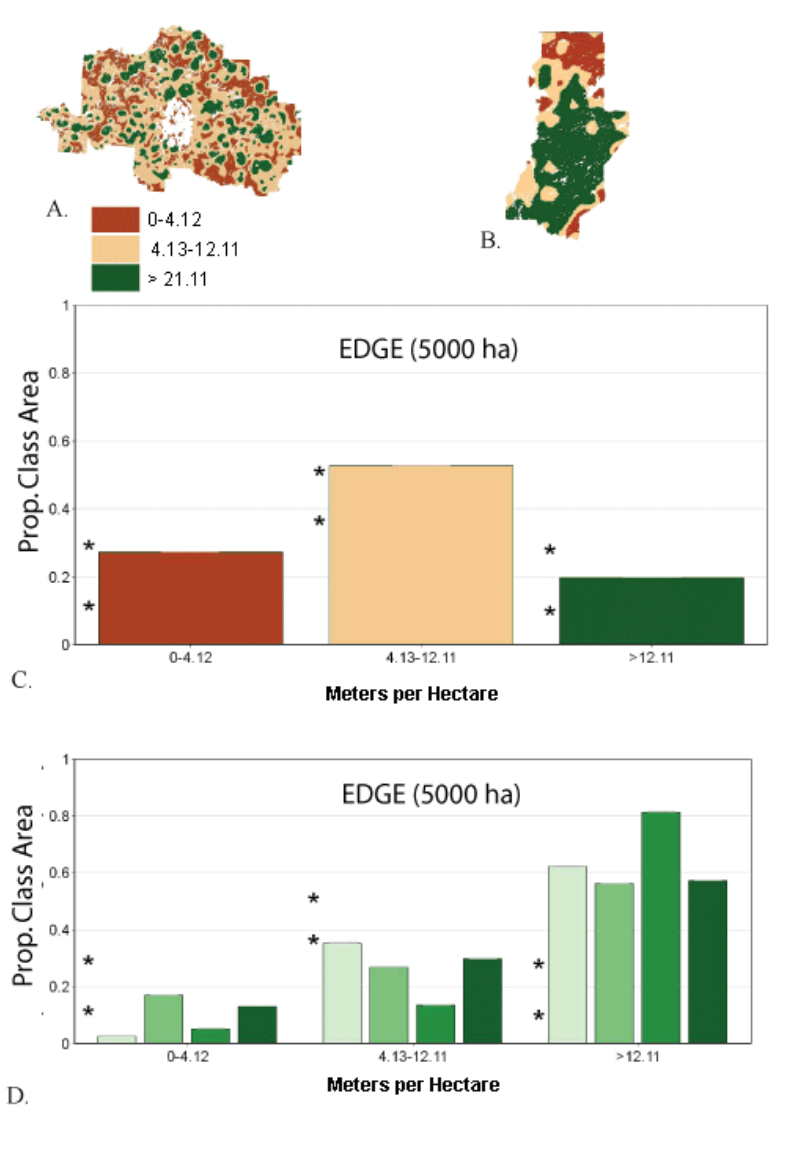
Fig. 7. Development and application of simulated range of natural variation (SRNV), and spatial pattern signatures: (A) 1 of 72 natural disturbance simulation maps (using BFOLDS) for ecoregion 3W, (B) projected map of EDGE (using Patchworks) for Nipigon Forest under the no spatial guides (NOSPATIAL) management scenario, (C) proportion of map-area with low, medium, and high contrast weighted edge density (EDGE), where asterisks are 25th and 75th percentiles for histogram heights among all 72 replications for ecoregion 3W, (D) proportion of Nipigon Forest map-area with low, medium, and high EDGE, among four scenarios, and where asterisks represent SRNV for EDGE from (C)